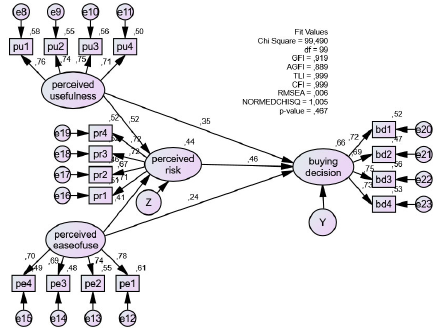
Fig. 2. The result of confirmatory factor analysis using four factors model